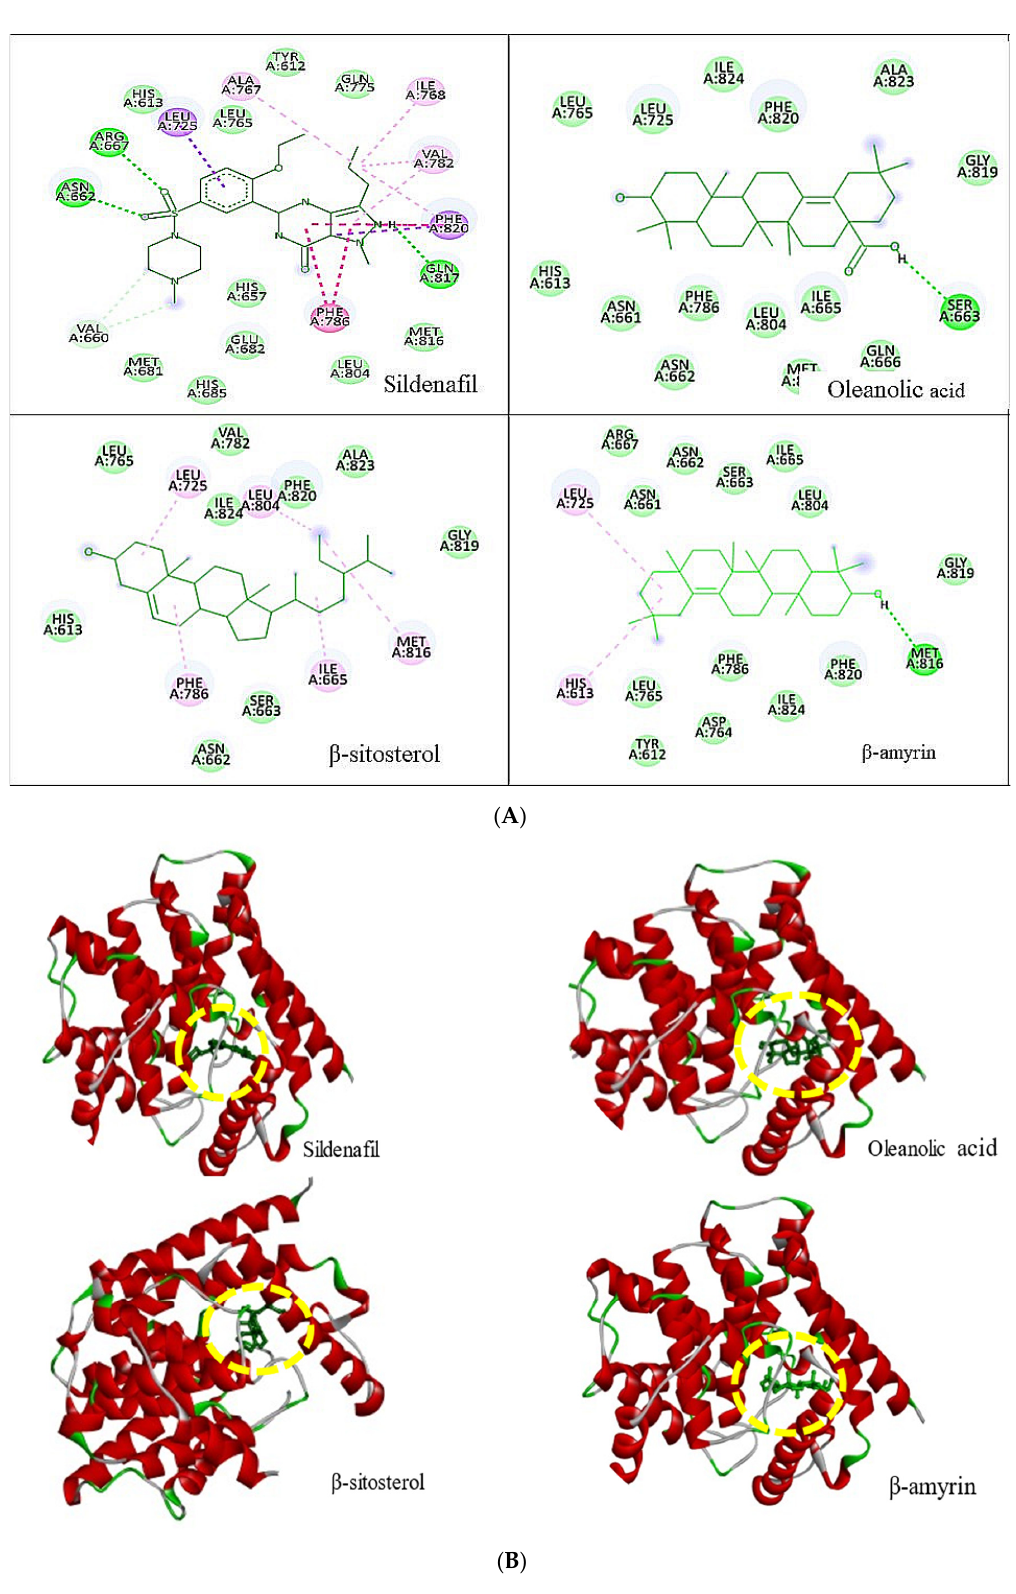
Figure 1. ( A ) Two-dimensional representation of the docked conformation of PDE-5 with ligands obtained after AutoDock vin docking. Green dashed lines represent conventional hydrogen bonds with the interacting amino acid residues. Pink lines indicate interactions between hydrophobic (alkyl–alkyl, π –alkyl or π – π ). ( B ) Three-dimensional representation of the docked conformation of the PDE-5 representation of docked conformation with ligands obtained after docking.